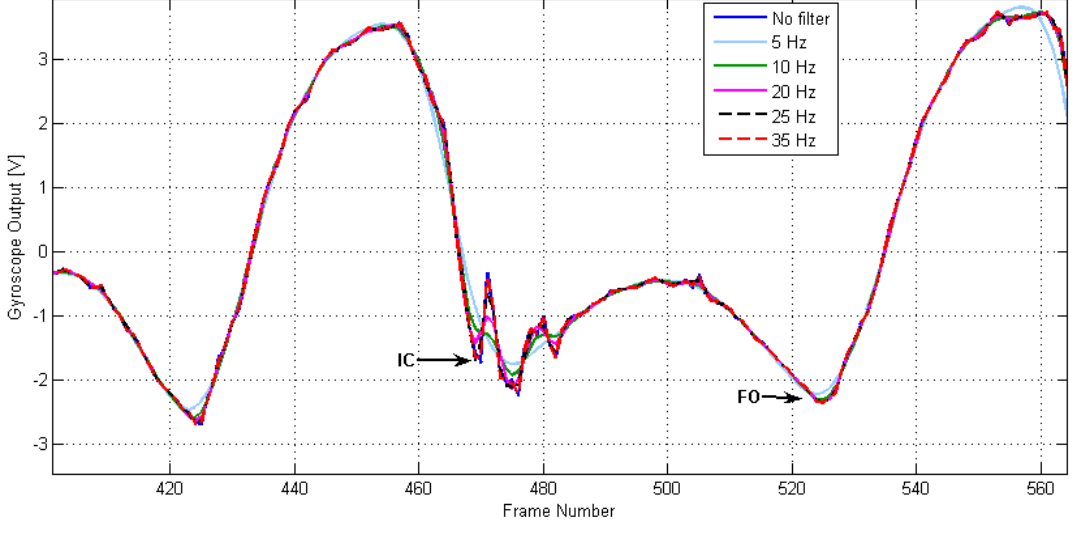
Figure 1. The effect of filtering using different cut off frequencies on the gyroscope signal from an unimpaired subject walking on level ground.